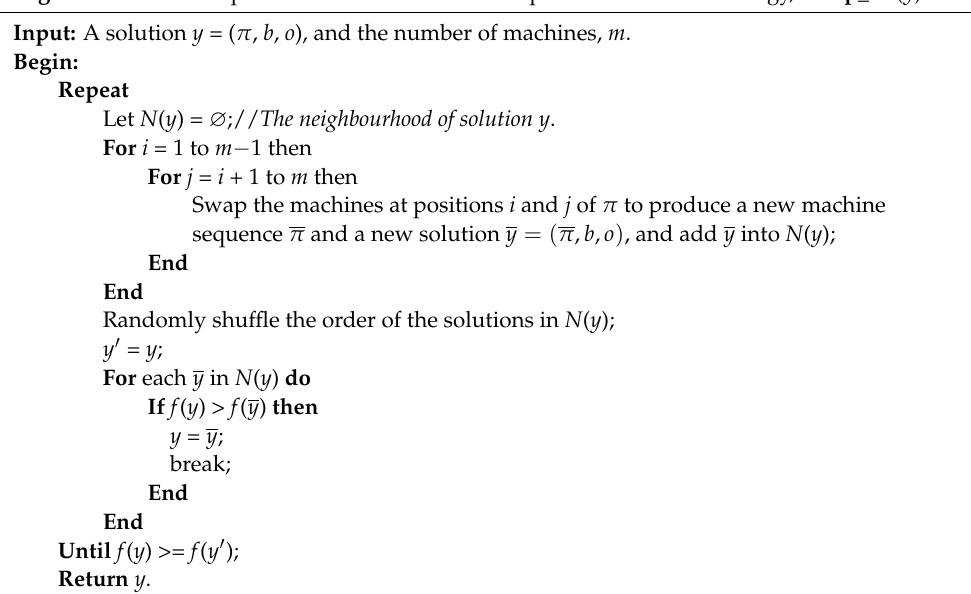
Algorithm 3. The 2-top local search with the first improvement search strategy, 2-Top_FI ( y